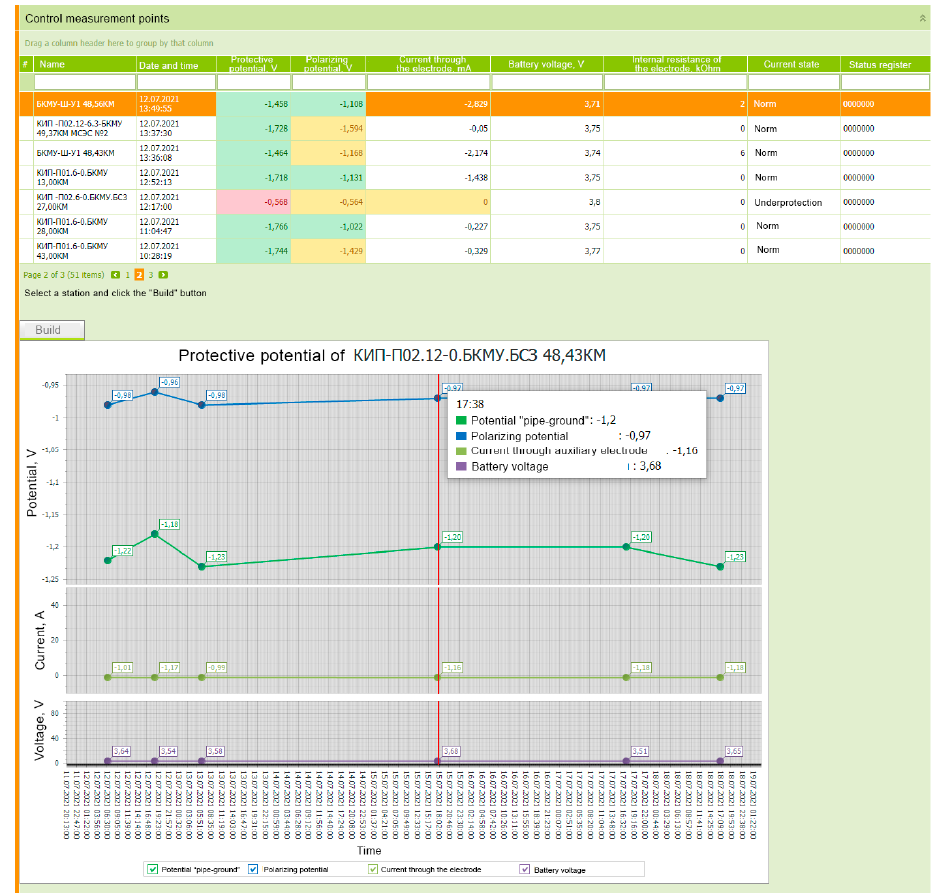
Figure 3. Web interface with monitoring data of the CMP.